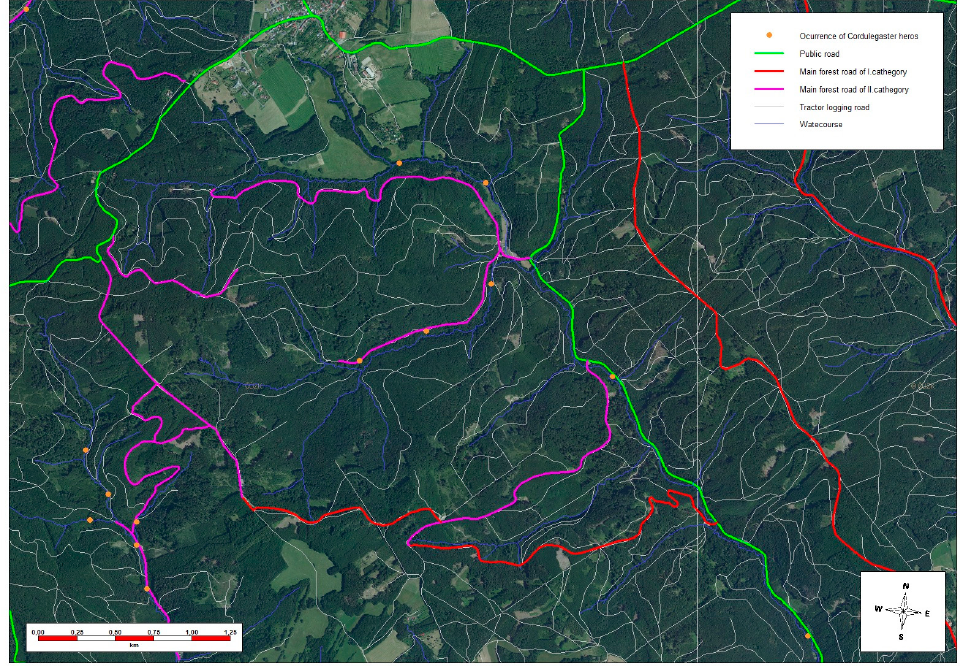
Figure 9. The northern half of the Kudlovický stream watershed in Ch ř iby hills (Czech Republic) with the network of forest transport roads and illustration of clearing and regeneration of forest stands.